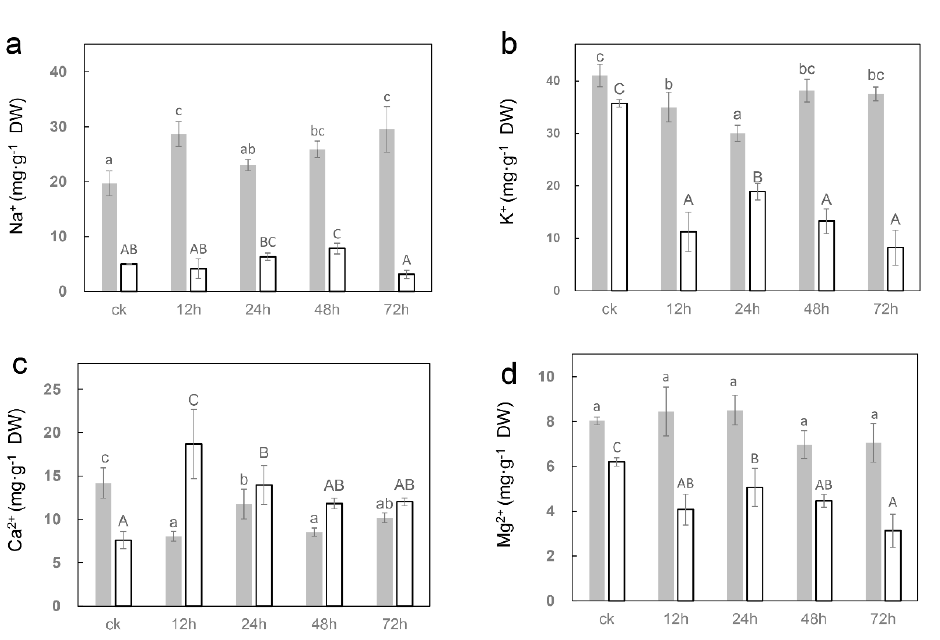
Figure 2. The changes in ion content under salt treatments in sugar beet O68 seedlings. ( a ) sodium ( b ) potassium ( c ) calcium ( d ) magnesium. The gray bars represent leaves and the white bars represent roots. The significance of leaves is marked with lowercase letters and that of roots is marked with uppercase letters. Triplicate biological replicates were performed. Different letters indicate significant differences according to Student − Newman − Keuls ( p < 0.05).